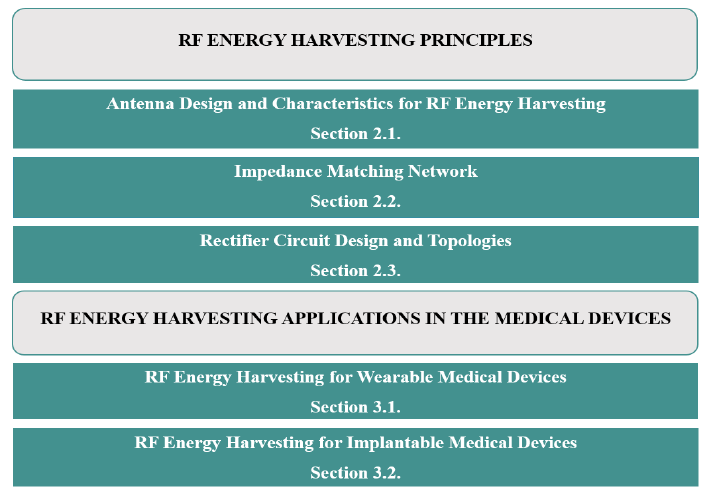
Figure 3. Organization of the